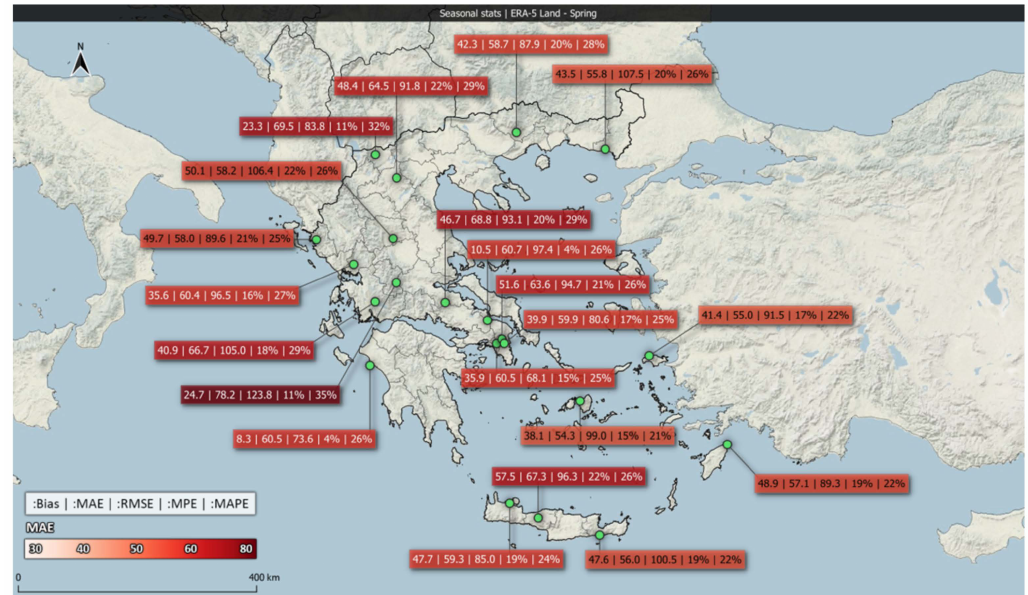
Figure 4. Bias (W/m 2 ), MAE (W/m 2 ), RMSE (W/m 2 ), and MPE and MAPE (both ranging from 0 to 1 for better visualization) between ERA5-Land and surface observations for spring (MAM) in the Greek area.